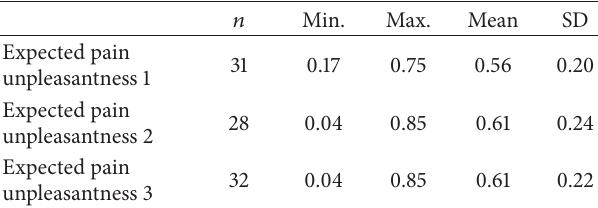
Table 1: Expected level of pain unpleasantness using the